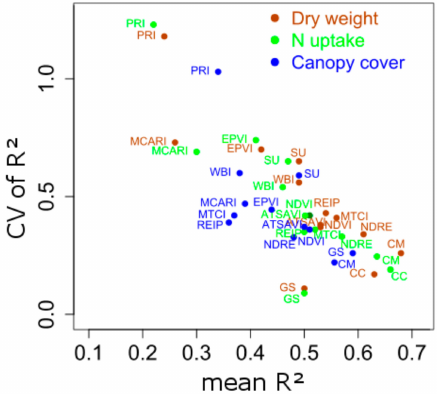
Figure 7. Coefficient of variation (CV) of R 2 plotted against mean of R 2 , calculated across four measurement days. Data of non-significant correlations was included for the